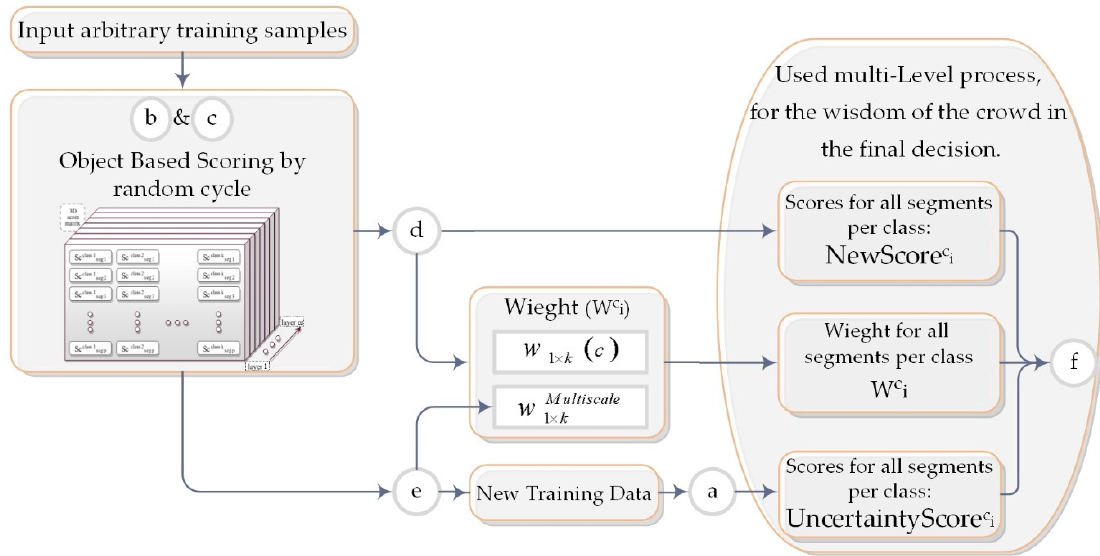
Figure 6. Workflow of the multi-level process in the final decision.